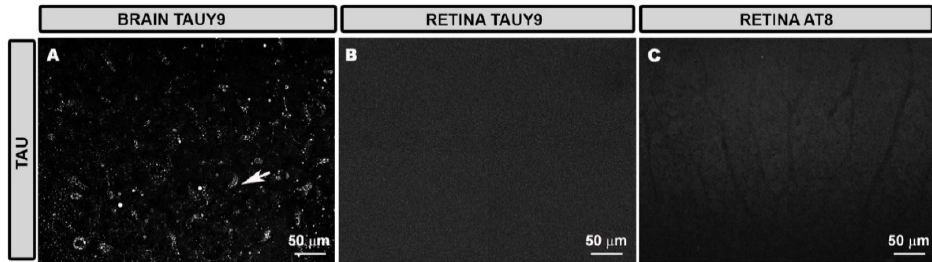
Figure 1. TAUY9 labeling in the hippocampus (arrow) ( A ), absence of TAUY9 ( B ), and AT8 ( C ) labelling in retinal tissue. ( B , C ) correspond to the inner complex retinal layers (ICL) of animals from the TAU group.